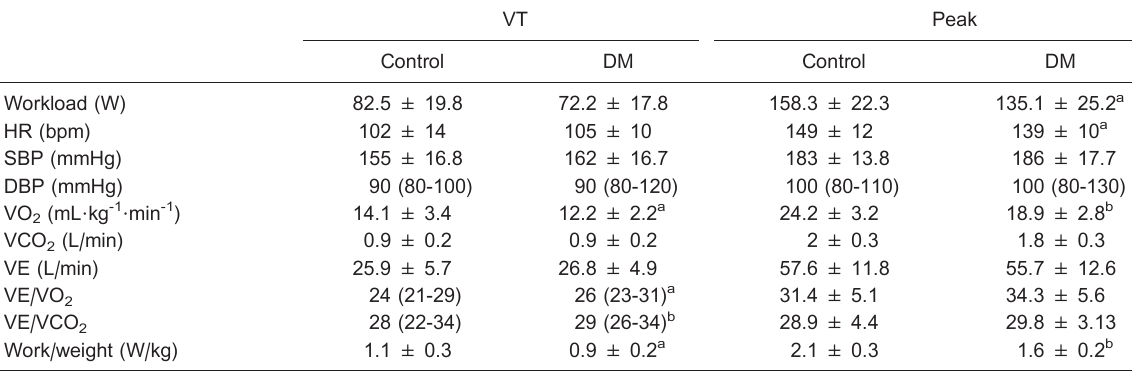
Table 2. Cardiopulmonary exercise test